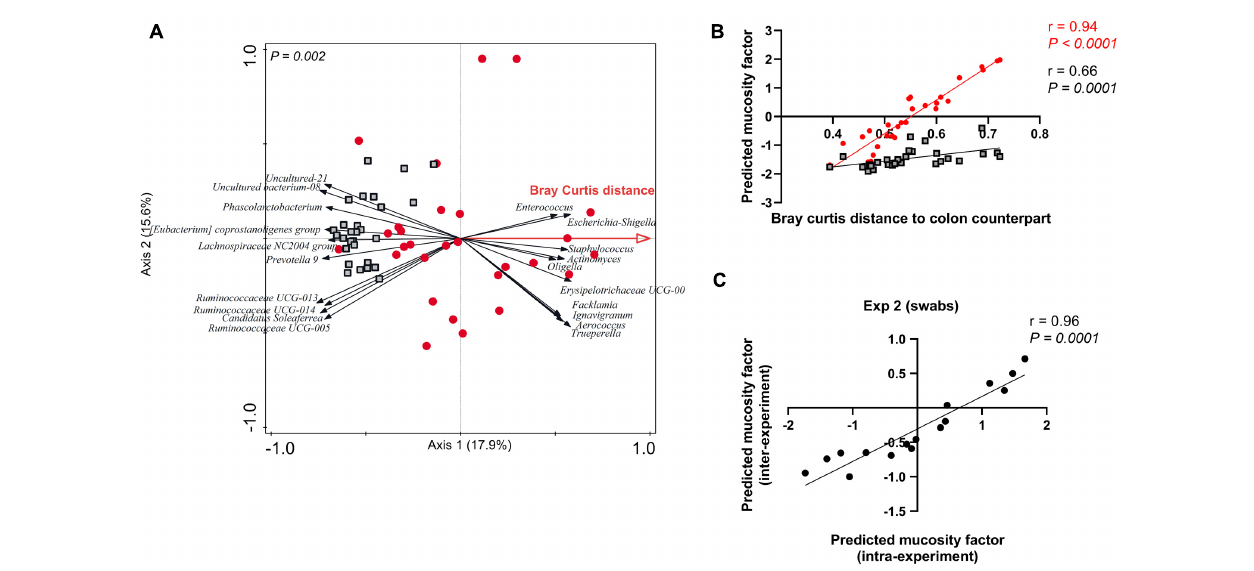
FIGURE 3 | Predicting the mucosity factor in rectal swab samples. (A) Redundancy analysis (RDA) of the mucosity factor “Bray Curtis distance to colon counterpart” (adjusted explained variation = 14.8%; P = 0.002), in swab samples only (red dots) creating an ordination space that enables the prediction of the mucosity factor. Colon samples (black outlined squares) were added as supplementary in this figure. (B) Spearman correlation between “Bray Curtis distance to colon counterpart” and the position scores (or CaseR scores) of swab (red dots) and colon (black outlined square; added as supplementary) samples in the mucosity factor predicting ordination space. (C) Spearman correlation between the Predicted mucosity factor (CaseR scores) intra- vs. inter-experiment. For the inter-experiment CaseR scores, experiment 2 swab samples were added as supplementary samples in the prediction ordination space created by experiment 1 swab samples ( Figure 3A ).